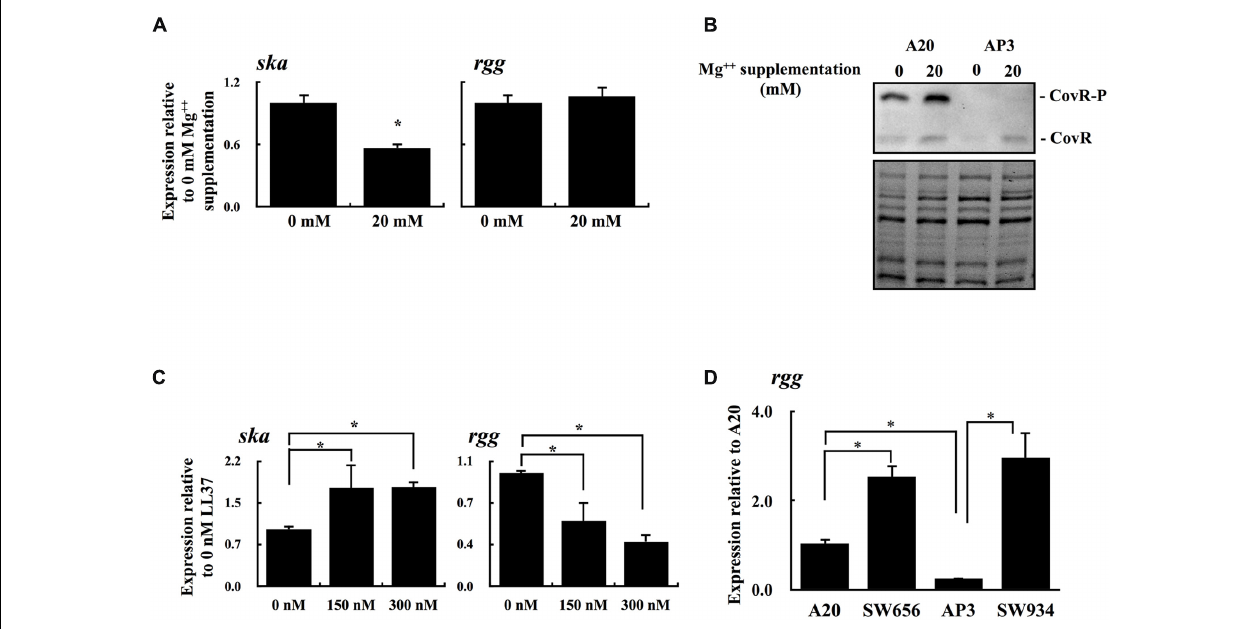
FIGURE 4 | The phosphorylation level of CovR protein and the expression of ska and rgg in A20 under Mg ++ and LL37 stimulation. (A) The expression of ska and rgg in A20 with or without the high concentration of Mg ++ stimulation. (B) Phos-tag Western blot for detecting the phosphorylated and non-phosphorylated CovR in A20 and AP3, with or without a high concentration of Mg ++ stimulation. CovR-P indicates the phosphorylated CovR protein; CovR indicates the non-phosphorylated CovR protein. The lower panel shows total protein as a loading control. (C) The expression of ska and rgg in A20 with 0, 150, and 300 nM of LL37 treatments. (D) The expression of rgg in A20, AP3, and their covR isogenic mutants (SW656 and SW934, respectively) in the stationary phase of growth. All qPCR analyses were performed using four independent RNA preparations in duplicate. The expression of ska and rgg were normalized to the gyrA . ∗ p < 0.05.